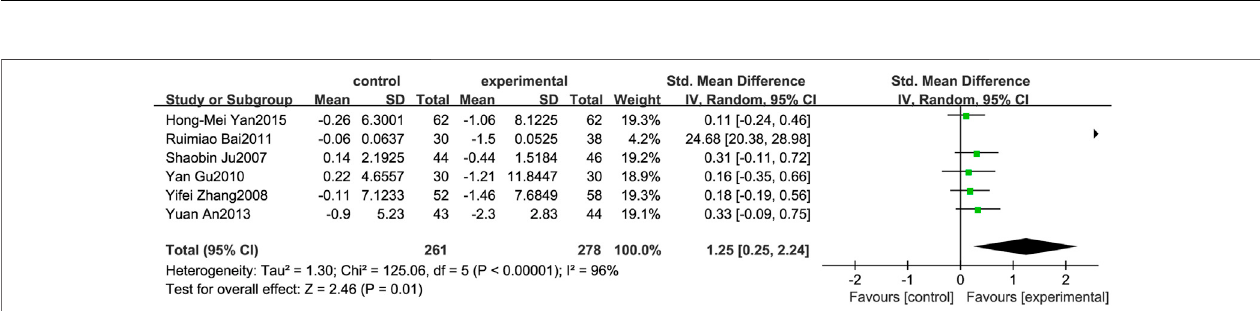
FIGURE 7 | Meta-analysis and migration analysis of the effect of berberine on homeostasis model assessment of insulin resistance. Forest plot illustrates the differences in changes in homeostasis model assessment of insulin resistance in adults with metabolic disease who did or did not receive berberine in 5 trials ( n (cid:1) 471). Themeandifference(bluesquares),95%CI(horizontallinesthroughbluesquares),andpooled-effectsizes(greendiamonds)werepresentedusing fi xed-effectsinverse- variance models.